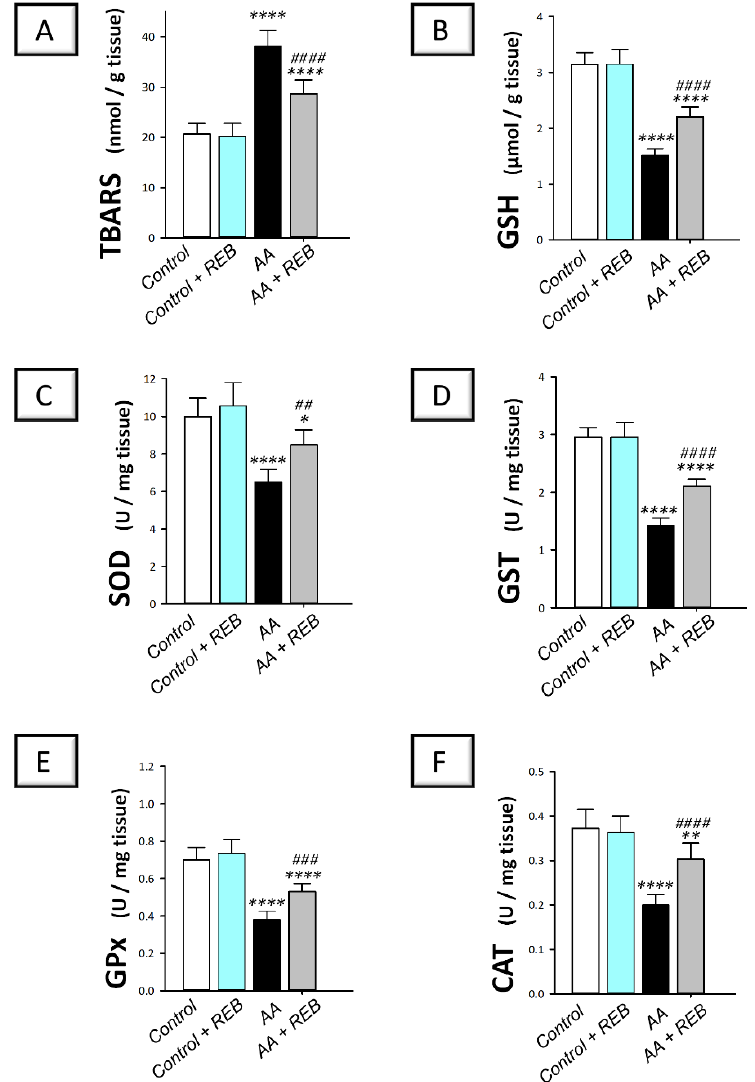
Figure 7. Rebamipide inhibits the colonic pro-oxidant signals and augments the antioxidant defenses in rats exposed to acetic acid-induced colitis. ( A ) Colonic lipid peroxides were measured as thiobarbituric acid reactive substances (TBARS). ( B ) Colonic reduced glutathione (GSH) levels. ( C ) Colonic superoxide dismutase (SOD) activity. ( D ) Colonic glutathione-S-transferase (GST) activity. ( E ) Colonic glutathione peroxidase (GPx) activity. ( F ) Colonic catalase (CAT) activity. Each bar represents the mean ± S.D. ( n = 8). A one-way ANOVA statistical test was conducted to analyze the significant difference among tested groups followed by a Tukey’s test. ** p < 0.01, or * p < 0.05, or **** p < 0.0001, significant from the control group. ## p < 0.01, ### p < 0.001, or # ### p < 0.0001, significant from the colonic injury group. REB, rebamipide; AA, acetic